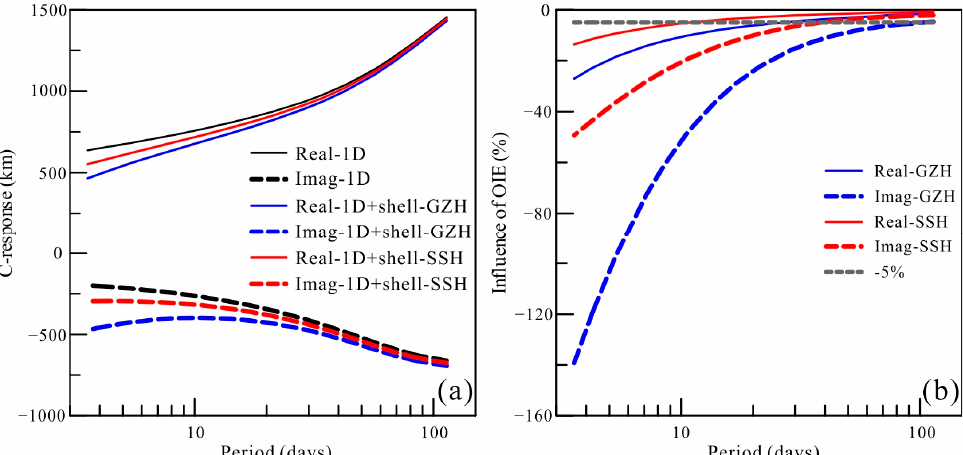
Figure 4. Ocean induction effects at Guangzhou (GZH) and Sheshan (SSH). ( a ) are the real and imaginary components of C-responses calculated by 1D model and 1D model with a surface shell comprised with ocean and land at GZH and SSH. ( b ) are the variations on the real and imaginary components of C-responses caused by the OIE.